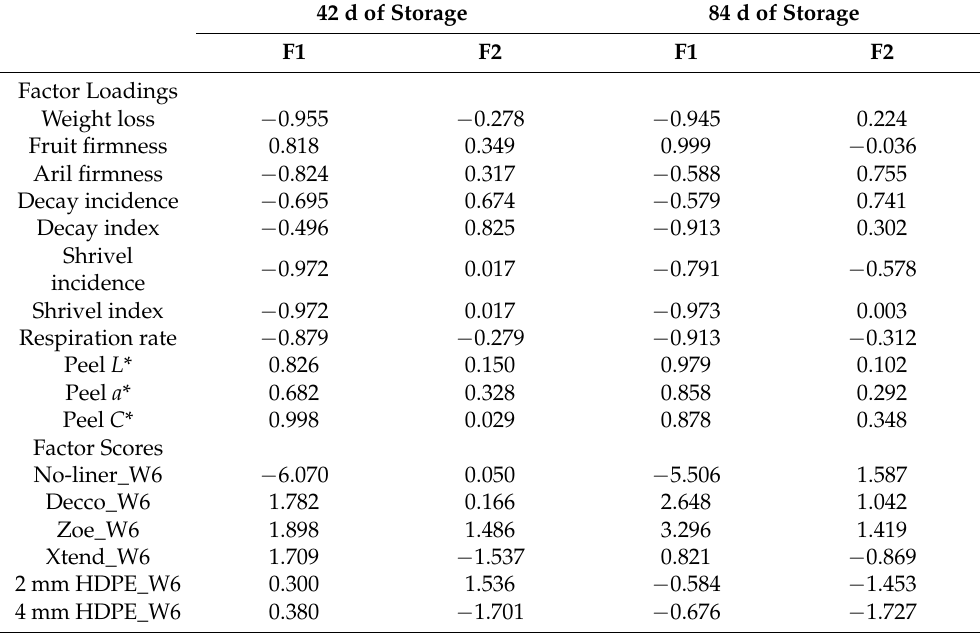
Figure 14. Principal component analysis of the first two factors (F1 and F2) due to physical and physiological attributes of pomegranate (cv. Wonderful) after 84 d of storage at 5 °C and 95% relative humidity (RH). W12 = 84 d. L *: lightness index describes surface color in the range from 0 (black) to 100 (white); a *: redness index describes surface color in the range from green (− a *) to red (+ a *); C *: chroma; HDPE: high density polyethylene. Table 7. Factor loadings and scores for the first two principal factors (F1 and F2) for pomegranate packed in no-liner and with different liners. HDPE: high density